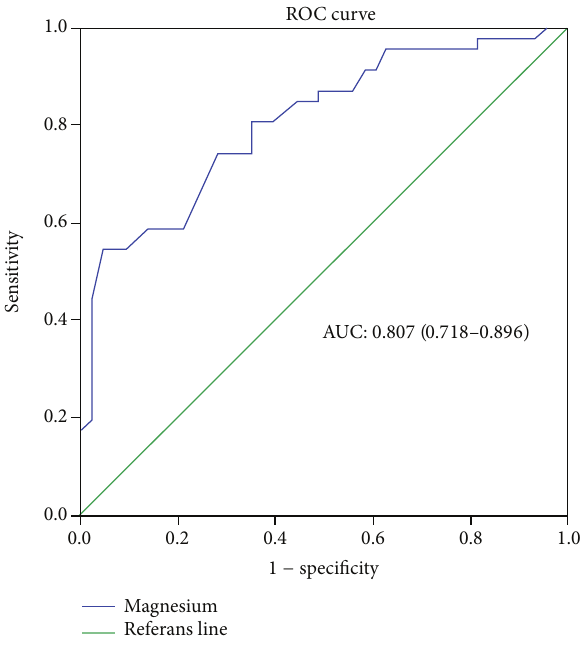
Figure 4: ROC curve analysis of serum magnesium level on frequency of